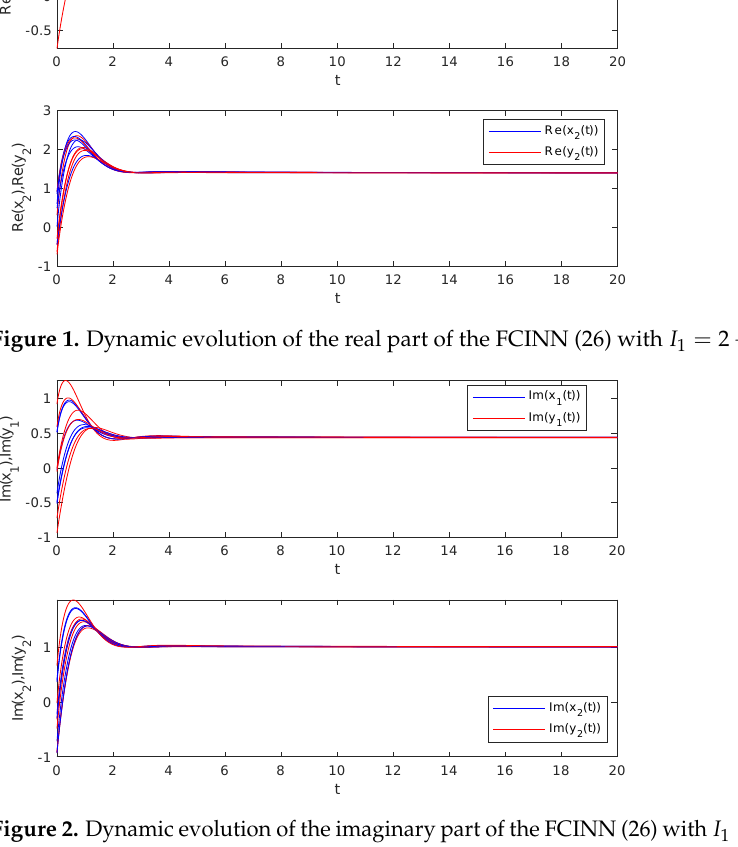
Figure 2. Dynamic evolution of the imaginary part of the FCINN (26) with I 1 = 2 + 2 i and I 2 = 5 + 4 i .